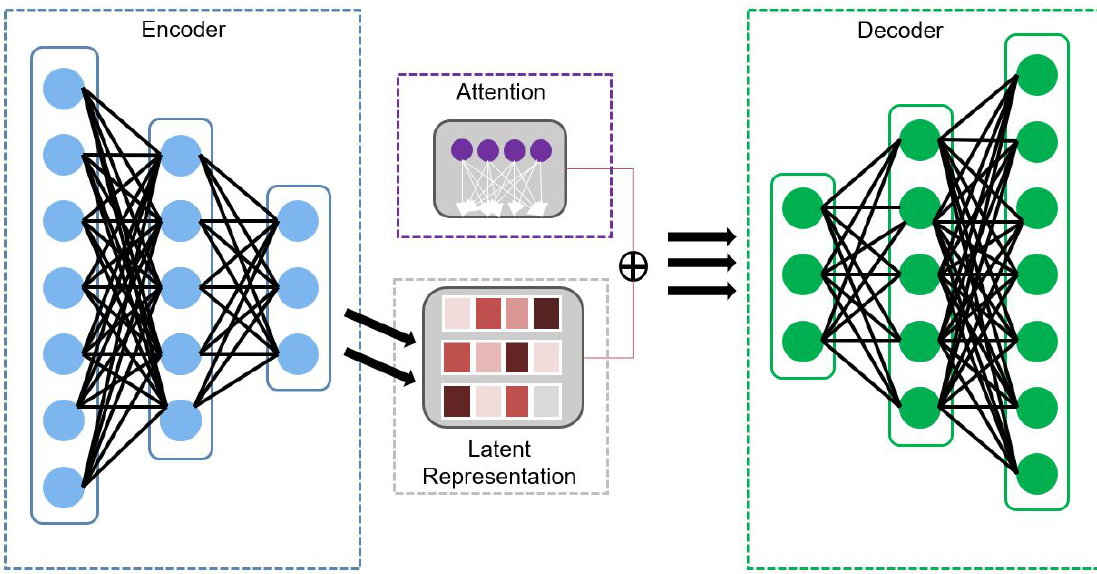
Figure 3. Architecture of the autoencoder model with the encoder, attention module, and the